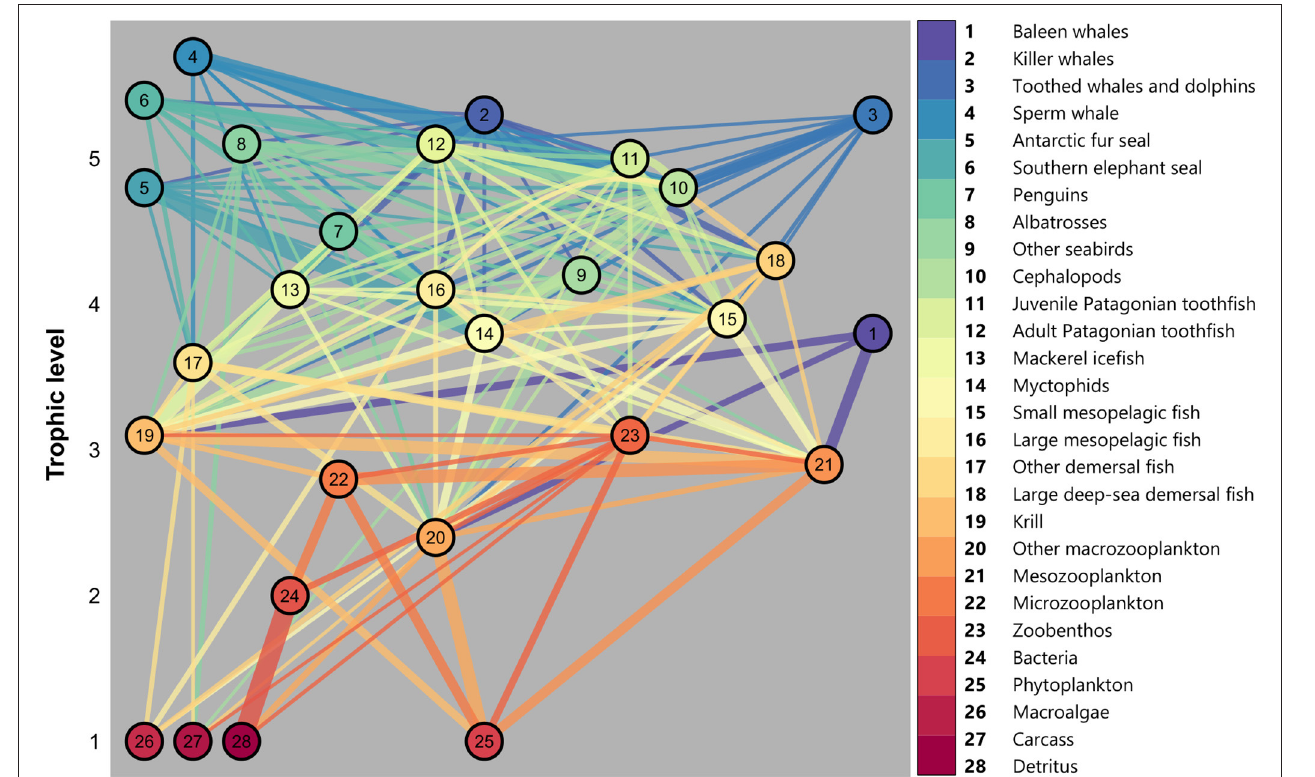
FIGURE 2 | Energy flow through each trophic level on the Kerguelen Plateau. Node number represents functional groups listed on the right, linkages between groups represent diet of each group (colored from predator to prey) and width of linkage indicates proportion of diet (see Subramaniam et al., 2020 for details).